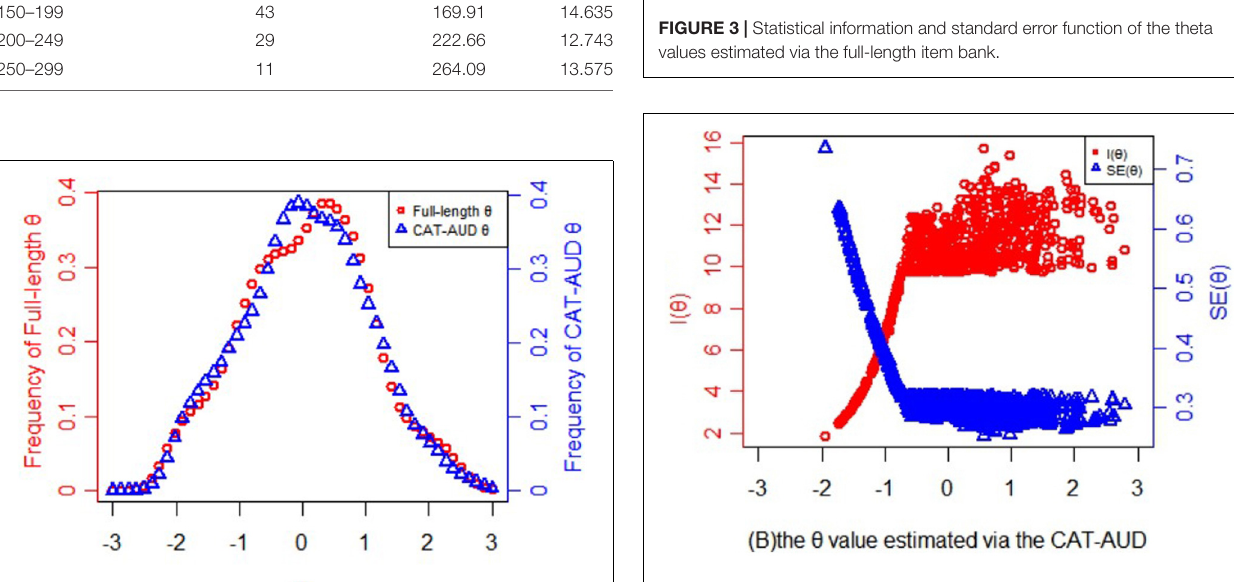
FIGURE 4 | Statistical information and standard error function of the theta values estimated via the CAT-AUD at a given SE level (SE ≤